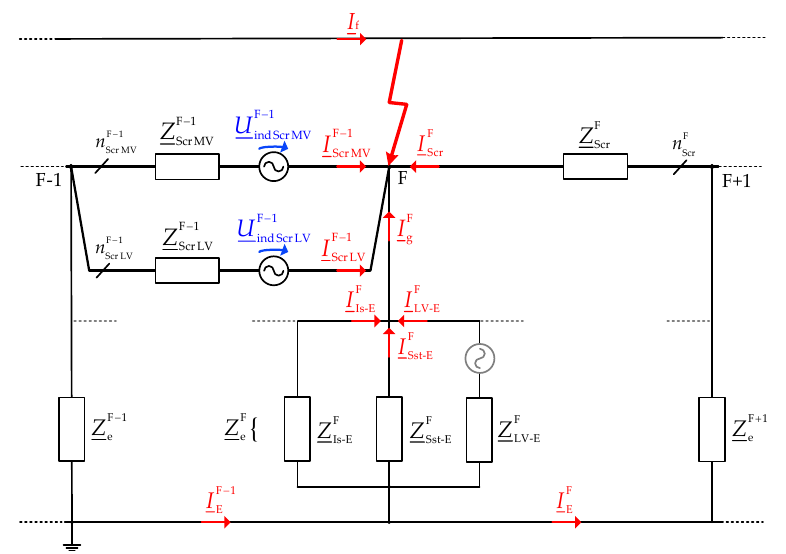
Figure 6. Current superposition at the fault node, shown for one stationary